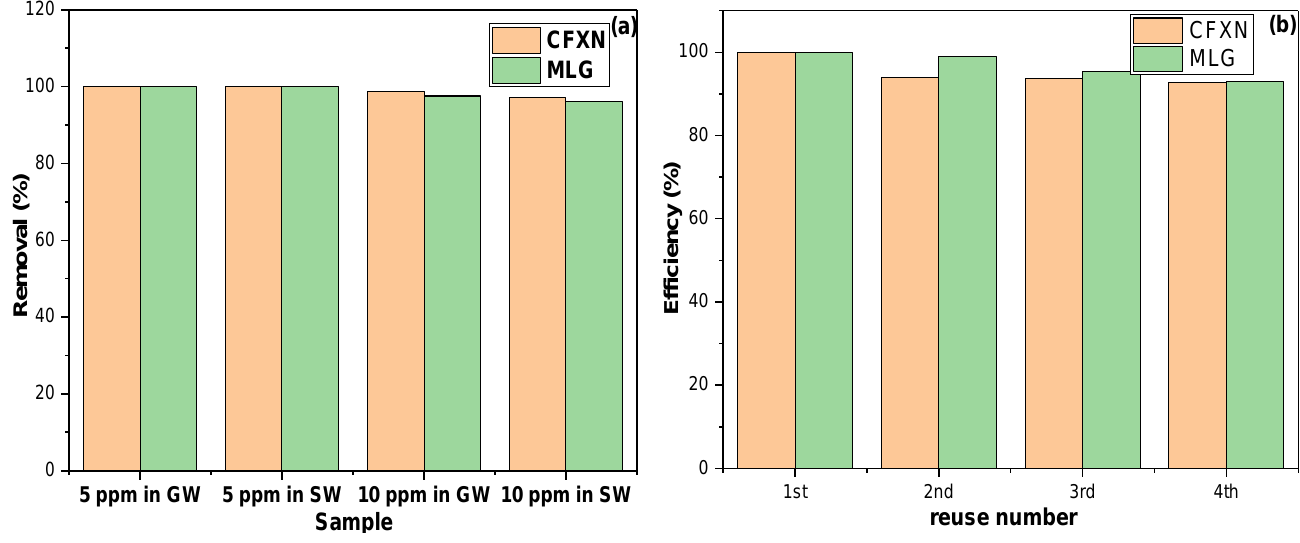
Figure 8. FTIR spectra of ( a ) free CFXN molecules and as adsorbed onto CNPs; ( b ) free MLG mole- cules and as adsorbed onto CNPs.